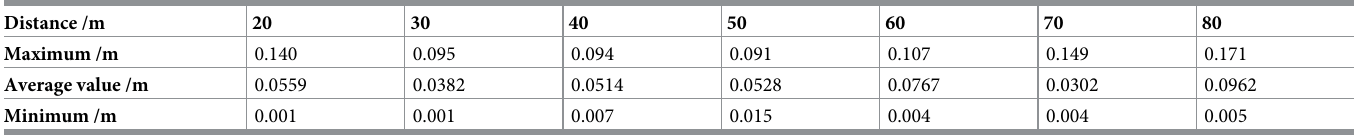
Table 3. Three error values for different base station separations.